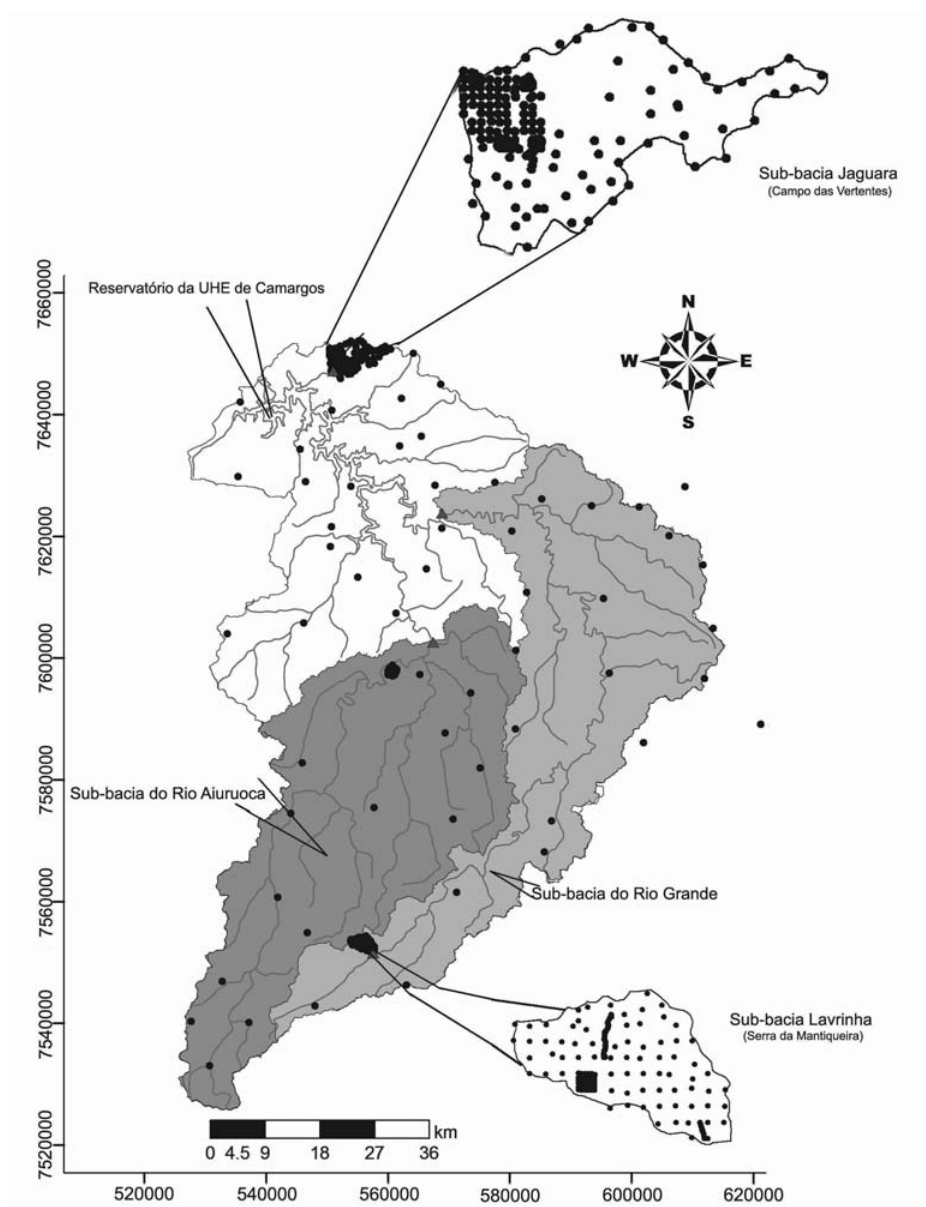
Figura 2. Localização e detalhamento dos pontos amostrados na bacia hidrográfica do Alto Rio Grande,